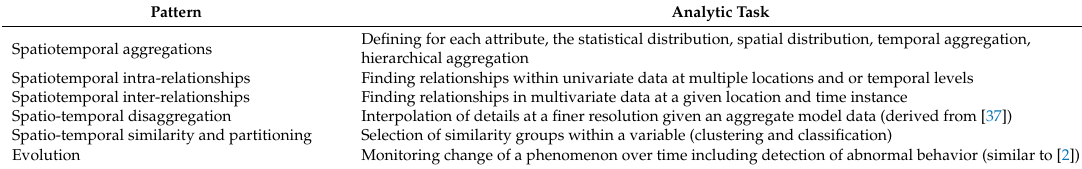
Table 4. Overview of patterns and their corresponding analytic task descriptions. Pattern Analytic Task